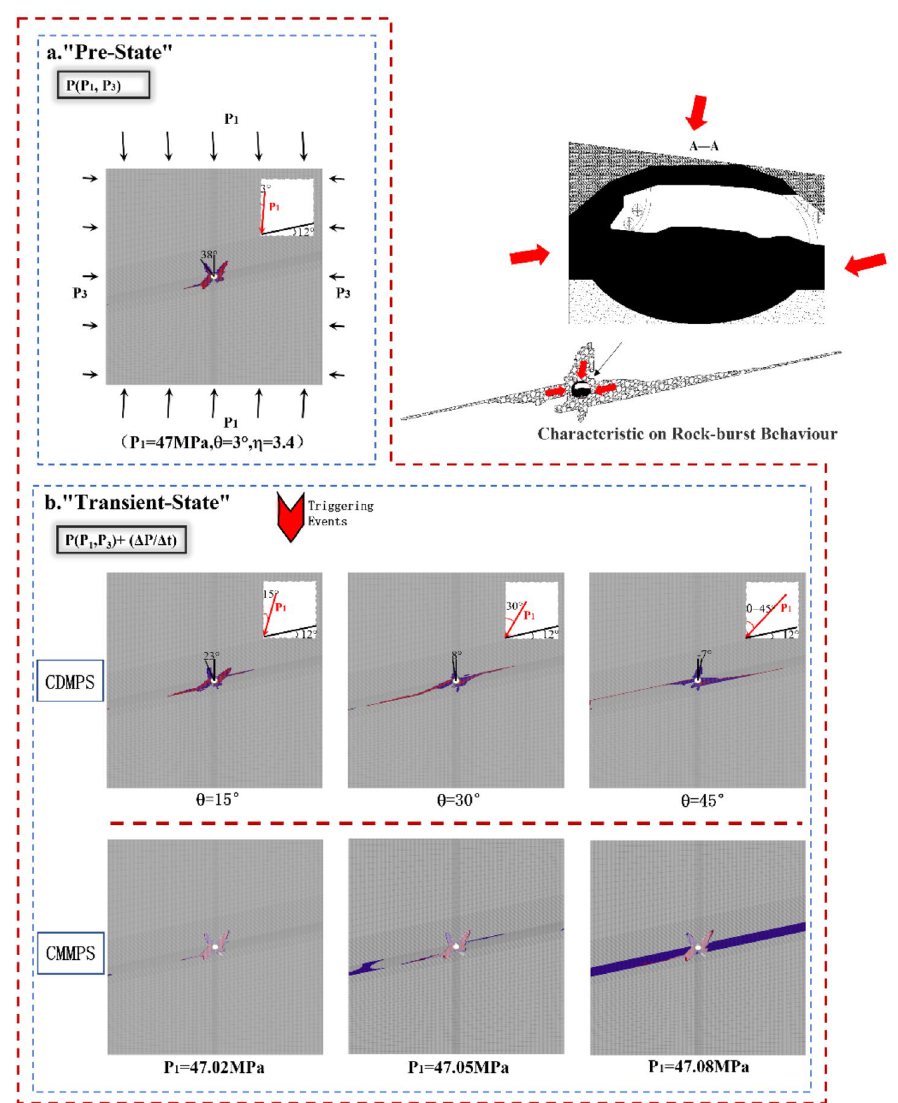
Fig. 8 “Transient” catastrophe process when rockburst occurs. Note: CDMPS represents “Change the deflection direction of the maximum principal stress”; CMMPS represents “Change the magnitude of the maximum principal